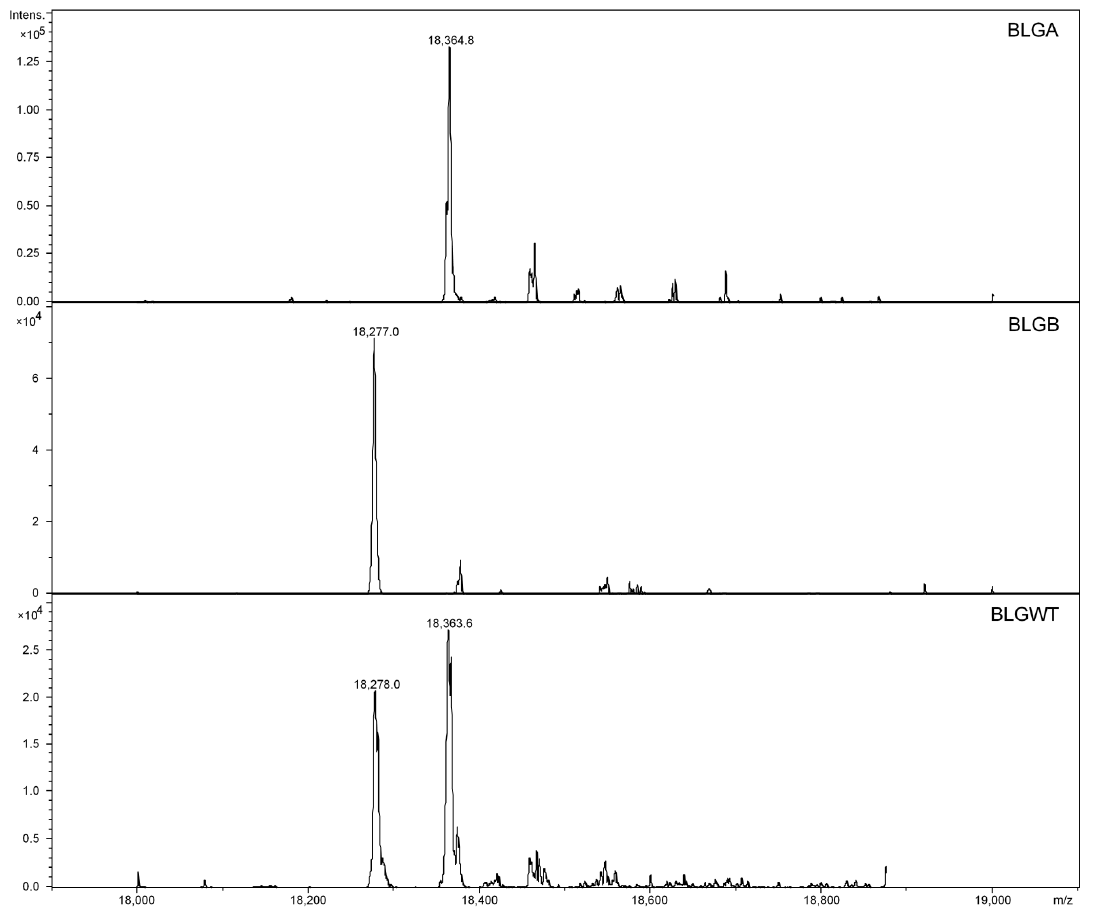
Figure 2. Deconvoluted spectra of BLGA, BLGB and BLGWT. After charge deconvolution, masses of 18,363.4 Da and 18,277.0 Da were found for BLGA and BLGB, respectively, indicating a charge distribution of 9+ to 15+, as shown in the profile spectrum (middle) of Supplementary Materials Figure S1. The observed masses are in line with the calculated mass values of BLGA and BLGB, as shown in Supplemen- tary Materials Table S1. Next, the lactosylated samples have been characterized by intact protein MS, of which the deconvoluted results are shown in Figure 3. When the lactosyl- ation levels increased, the net charge decreased, caused by linkage of lactose amine groups, shielding positive charges, resulting in shorter migration times and lower MS re- sponses as incubation times increased. Apparently, at t = 0, some lactosylation already occurred spontaneously. At t = 3 and t = 8, a shift to the higher masses can be observed, no non-lactosylated protein remained and all protein contained 3, 4, 5, 6, 7, 8 or 9 lactose units. The mass shift continued until t = 24, with overlapping lactosylation levels, where the difference in lactose units per protein was only 1 lactose unit between t = 16 and t = 24; seemingly, a maximum is reached.